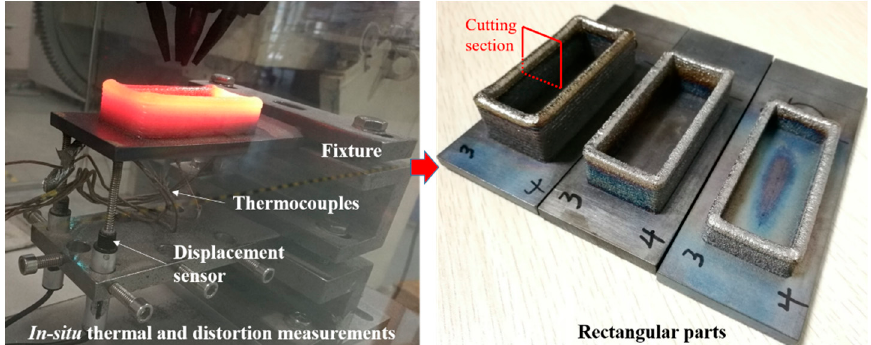
Figure 1. In-situ measurement setup during the laser directed energy deposition (L-DED) process.